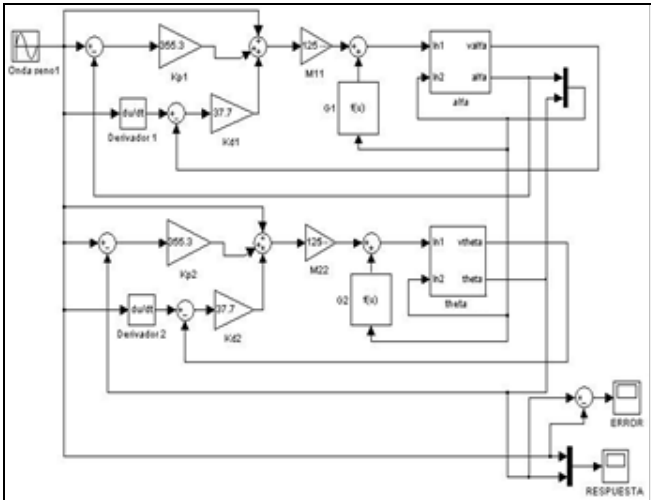
Figura 8: Diagrama de bloques en Simulik. Fuente: Autores, (2017).